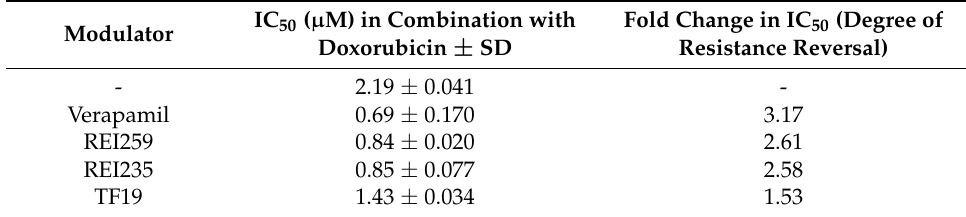
Figure 1. Flow cytometric quantification of intracellular doxorubicin fluorescence in CCRF-CEM and CEM/ADR5000 cells treated with doxorubicin alone, doxorubicin and artemisinin-, egonol-, and thymoquinone-based hybrids, or doxorubicin and the P-glycoprotein inhibitor verapamil, as a positive control after incubation for 24 h. Table 2. IC 50 values of CEM/ADR5000 upon treatment of doxorubicin combined with verapamil, or three hybrids, as measured by resazurin assays and the degrees of resistance reversal. Verapamil (20 µ M) or derivatives (10 µ M) were used in combination with doxorubicin (0.1–100 µ M). Experiments were repeated at least twice, and for each concentration at least in triplicate.